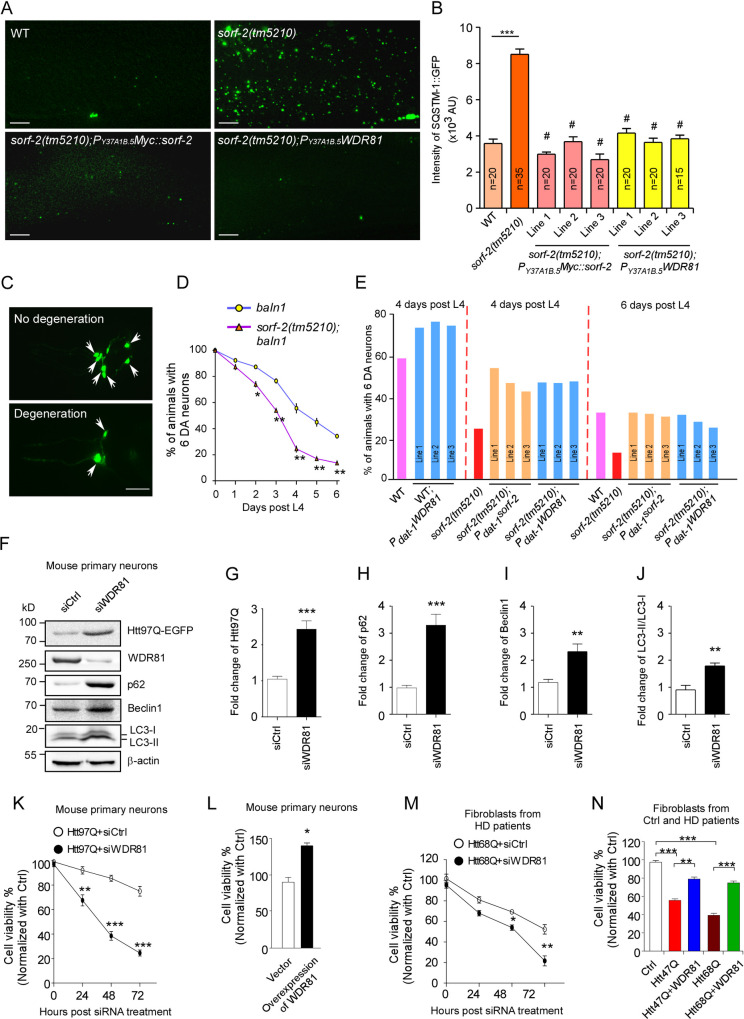
WDR81 has an evolutionarily conserved effect on autophagic clearance of protein aggregates and maintenance of cell viability.(A) C. elegans sorf-2(tm5210) mutants accumulate p62/SQSTM-1::GFP foci in hypodermal cells, which is rescued by expression of either C. elegans sorf-2 or human WDR81 driven by a hypodermal cell-specific promoter (PY37A1B.5). (B) Quantification of SQSTM-1::GFP foci in wild-type, sorf-2(tm5210), and sorf-2(tm5210) animals carrying transgenes expressing sorf-2 or WDR81. The indicated numbers of animals from each genotype were analyzed for hypodermal SQSTM-1::GFP intensity (arbitrary units, AU); 3 independent lines are shown for sorf-2 or WDR81 transgenes. *, compared with WT group. #, compared with sorf-2(tm5210) group. (C and D) GFP-positive DA neuron loss induced by α-synuclein is exacerbated in sorf-2(tm5210) mutants. Representative images of a baIn1 (Pdat-1:: α-synuclein+ Pdat-1:: GFP) animal with all 6 DA neurons (white arrows) and a baIn1 animal with 2 DA neurons are shown in the left panels. Quantifications of DA neuron loss in baIn1 and sorf-2(tm5210); baIn1 animals are shown in the right panel (D). Data were derived from 3 independent quantifications in which ≥40 animals of each genotype were scored for DA neurons at every time point. (E) Overexpression of sorf-2 or WDR81 rescues GFP-positive DA neuron loss induced by α-synuclein in sorf-2(tm5210) mutants. ≥50 animals were scored for DA neurons in each of 3 independent transgenic lines expressing sorf-2 or WDR81 driven by a neuron-specific promoter (Pdat-1). Data presented are from animals at the age of 4 or 6 days post the L4 molt. (F-J) Knockdown of WDR81 resulted in accumulation of Htt97Q aggregates and endogenous autophagic proteins in mouse primary neurons. Primary neurons were isolated from cortex of C57/B6 mouse brains. Representative images were shown from 3 independent experiments (F). Statistical analysis was performed to test fold changes of indicated proteins (G-J). (K) Viability of mouse primary cortex neurons transiently expressing Htt97Q-EGFP without or with siWDR81 treatment. (L)Viability of mouse primary cortex neurons transiently expressing Htt97Q-EGFP without or with overexpression of wild-type WDR81. (M) Viability of Htt68-containing fibroblasts from HD patients without or with siWDR81 treatment. (N) Viability of fibroblasts from two HD patients with two different polyQ expansions (Htt47Q and Htt68Q), was restored by overexpression of wild-type full-length WDR81. Scale bars represent 20 μm in all panels. For quantifications, means±SEM were derived from three independent experiments and analyzed using t-test or ANOVA. * P <0.05, ** P <0.01, *** P <0.001.